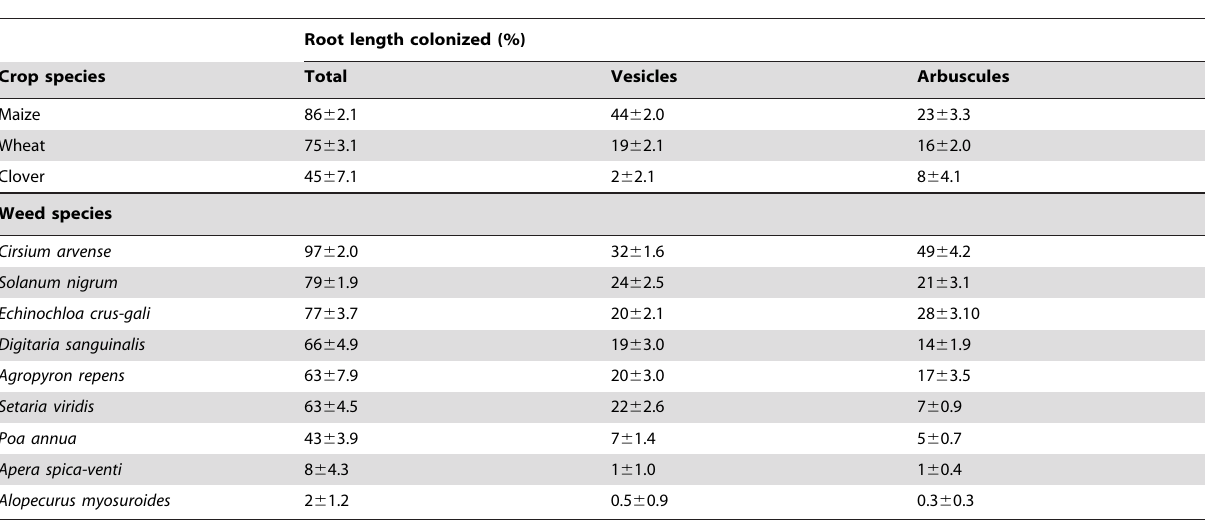
Table 2. Percentage of root length colonized by G. intraradices in experiment